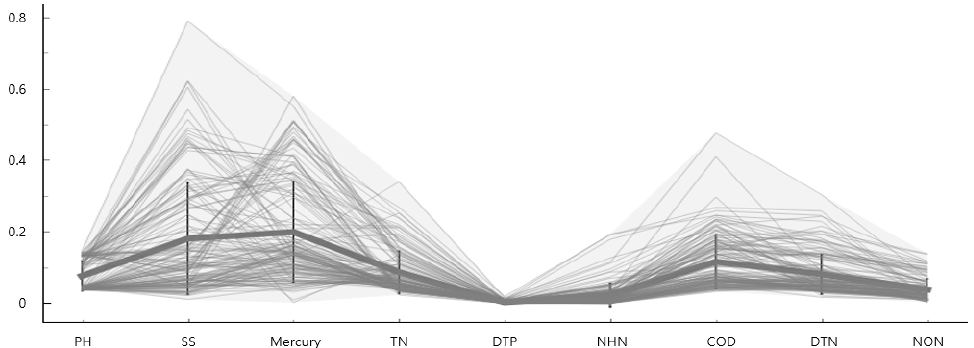
Figure 9. Plot of predicted